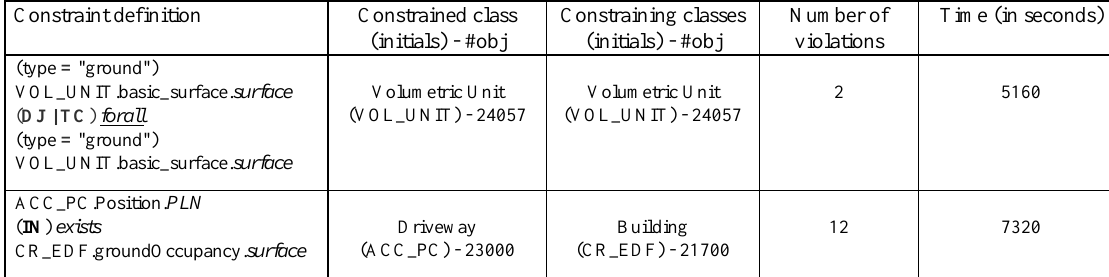
Table 1. Time required for testing the two most time consuming spatial integrity constraints (see